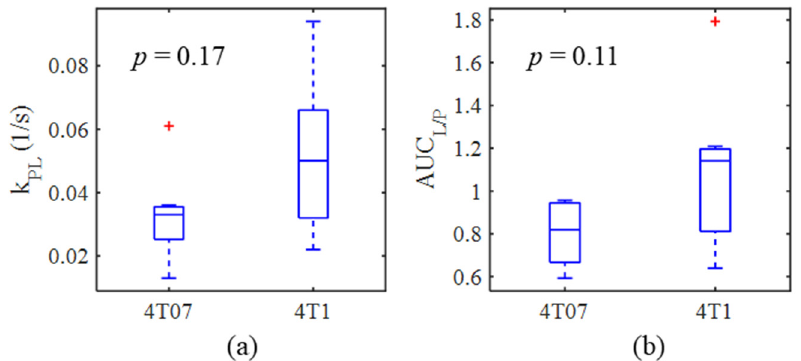
Figure 3. Boxplots comparing the distribution of ( a ) k PL and ( b ) AUC L/P between metastatic dormant 4T07 and highly metastatic 4T1 tumor models. Box plots represent the median with upper and lower limits representing the 25th and 75th percentiles, whiskers the minimum and maximum, and red crosses the outliers.